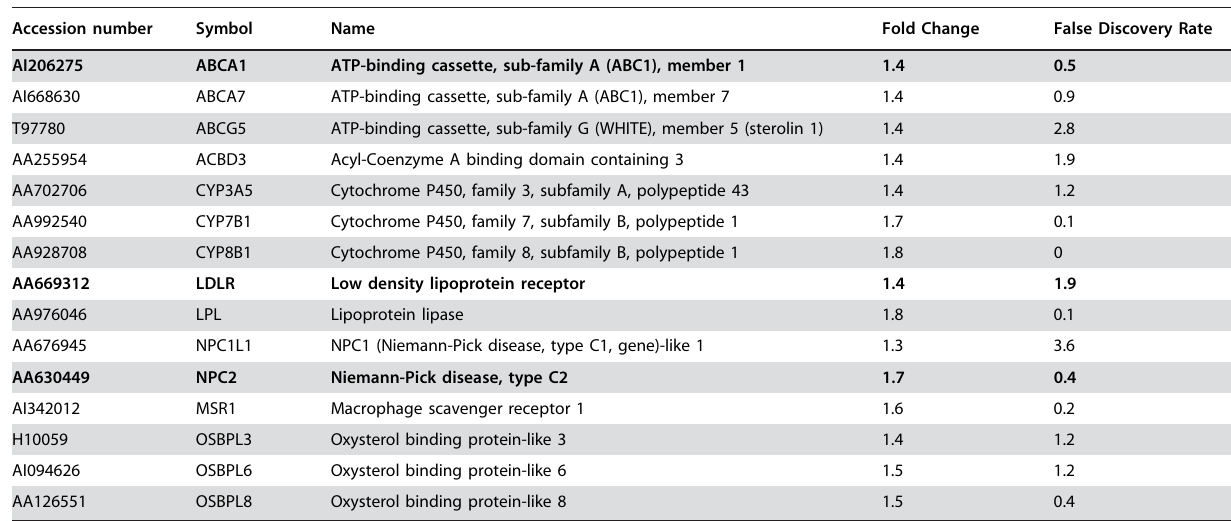
........................................................................ Table 1. Genes involved in Cholesterol Homeostasis are upregulated in NPC cells. .. ... .... ... ... .... ... ... .... ... ... .... ... ... .... ... ... .... ... ... .... ... ... .... ... ... .... ... ... .... ... ... .... ... ... .... ... ... .... ... ... .... ... ... . Accession number